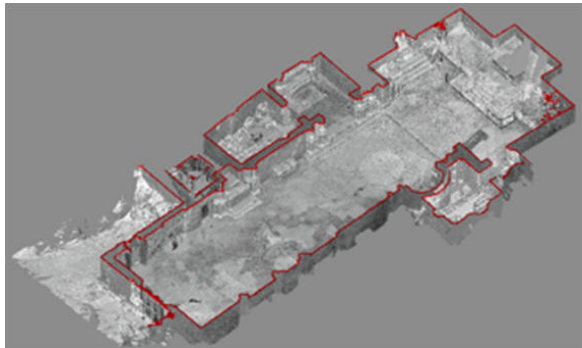
Figure 6. Surveying project